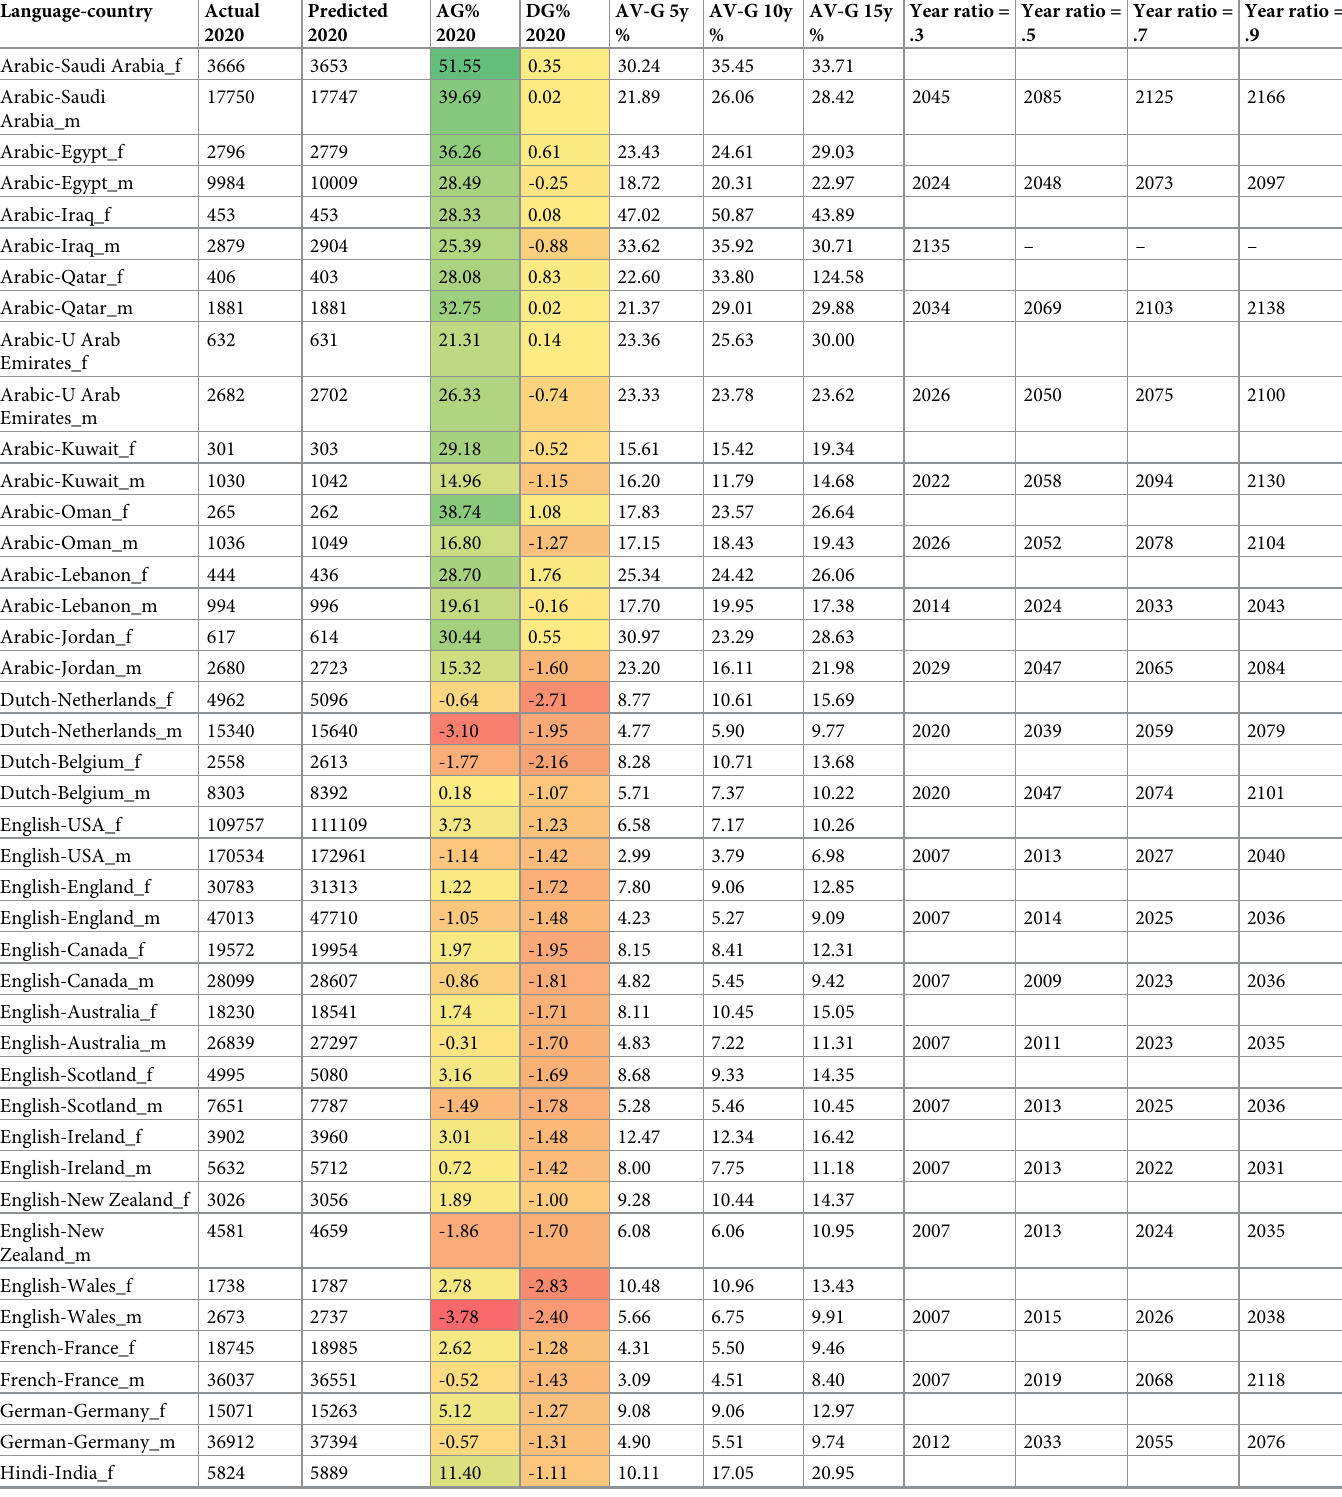
Table 2. Statistics of temporal trends of productivity of male and female scientists based on the A-C method.